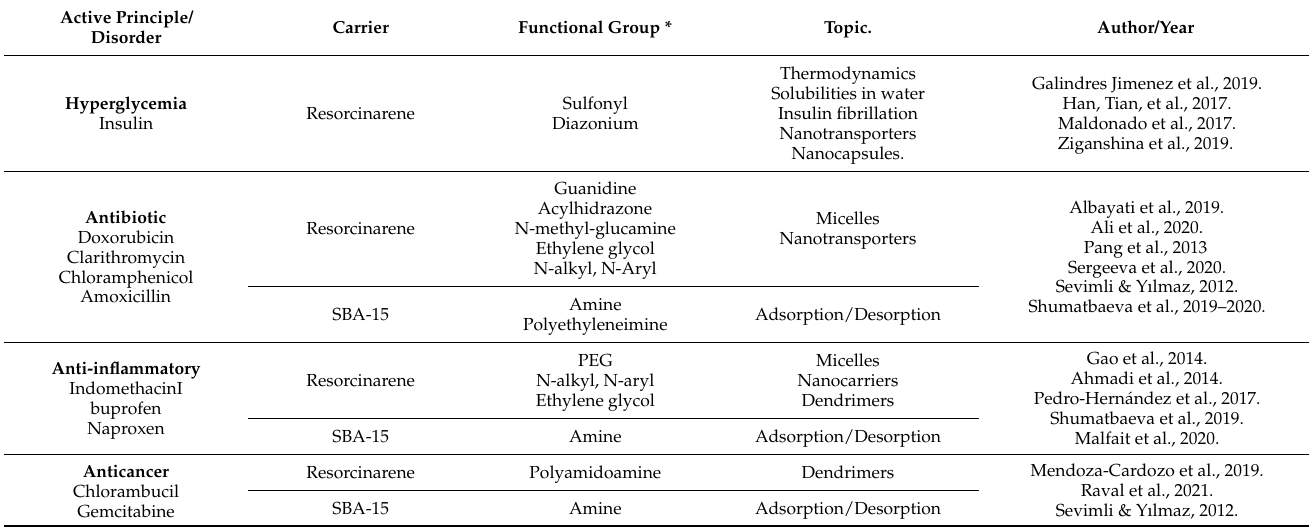
Table 1. Summarize: Uses of Resorcin[4]arenes and SBA-15 in drug delivery. Active Principle/ Disorder